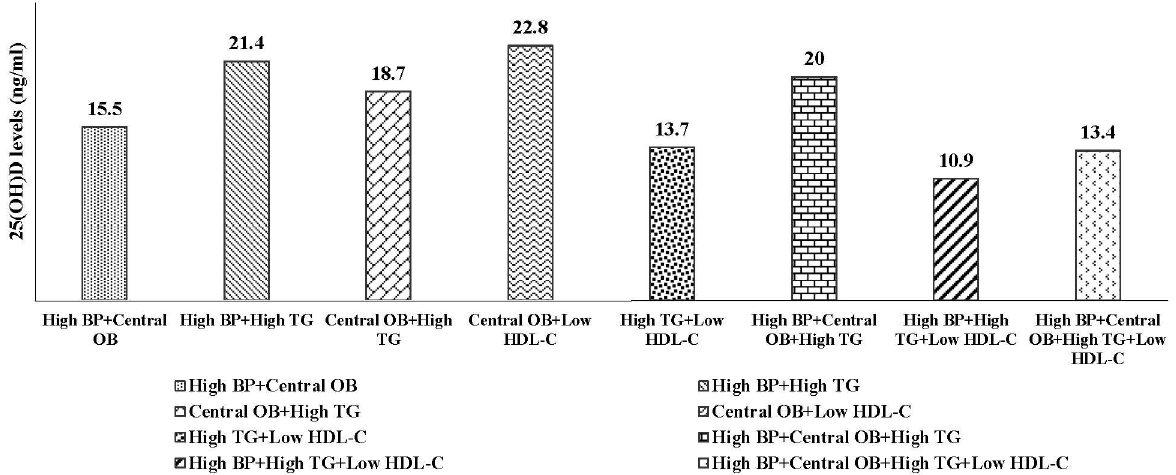
Fig 1. Comparison of mean serum 25(OH)D levels of MetS combinations. 25(OH)D, 25-hydroxyvitam in D; MetS, metabolic syndrome; BP, blood pressure; OB, obesity; TG, triglyceride; HDL-C, high density lipoprotein cholesterol. Comparison of mean serum 25(OH)D levels of subjects with various MetS combinations. NS: Non Significantly difference by serum 25(OH)D levels for the kruskal- wallis